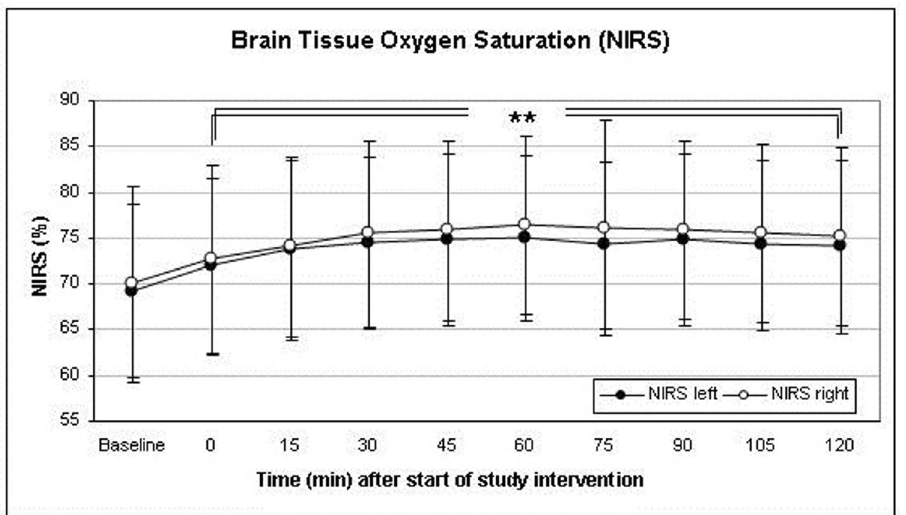
Figure 3. Changes of cerebral tissue oxygen saturation (S ti O 2 ) was measured by near infrared spectroscopy (NIRS). S ti O 2 increased over both hemispheres with a peak after 60 min. Thereafter, the beneficial effect of the study intervention seemed to weaken. (*p < 0.05, **p < 0.01, ***p < 0.001). Data presented as Mean ± SD; 1-way ANOVA for Repeated Measurements; *p < 0.05, **p < 0.01, ***p < 0.001, plots and error bars presented as Mean ± SD (standard